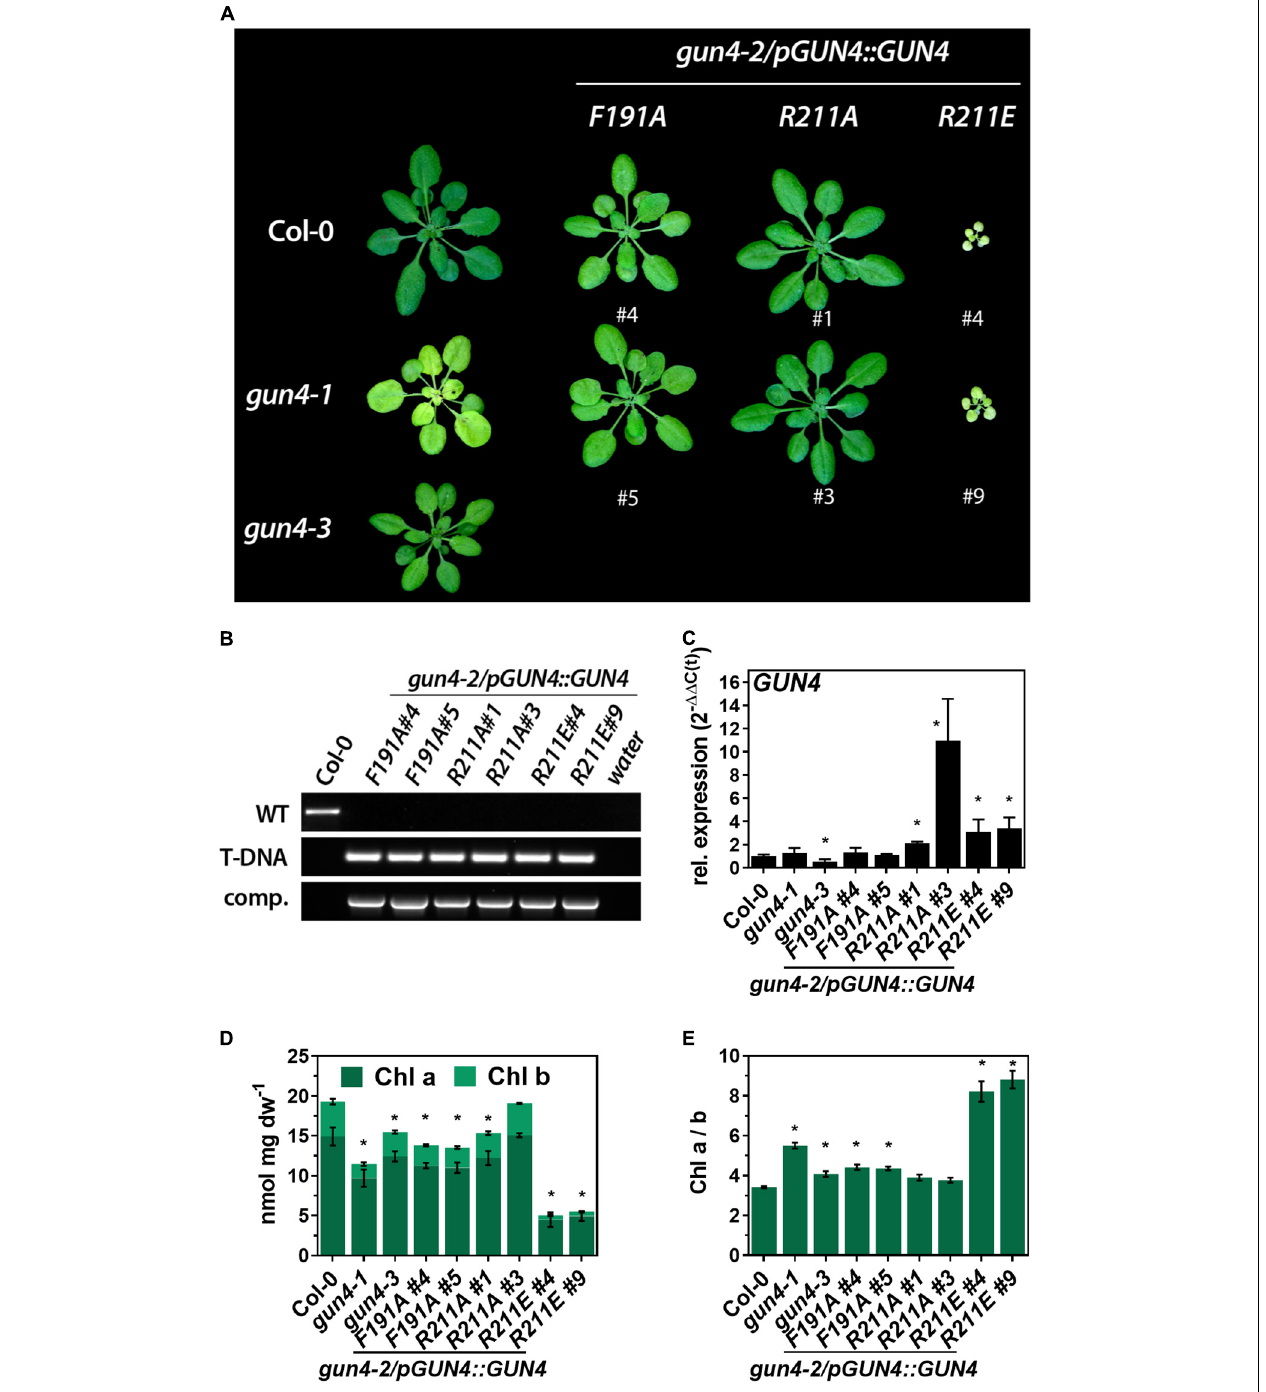
FIGURE 2 | Complementation of the gun4-2 knock out mutant with genomic constructs encoding for GUN4 ( F191A ), GUN4 ( R211A ), and GUN4 ( R211E ). (A) Phenotype of 5-week-old WT (Col-0) and mutant plants grown on soil under short-day conditions at 100 µ mol photons – 2 s – 1 . In addition, gun4-1 and gun4-3 knock out plants are shown. (B) PCR-based confirmation of the gun4-2 knock out background and presence of the complementation construct in the mutant lines shown in panel (A) using primers for the amplification of the GUN4 WT-allele (WT), the SALK_026911 T-DNA insertion (T-DNA) and the complementation construct (comp.) (C) Expression of GUN4 mRNA relative to Col-0 and SAND as reference gene [2 − ddC ( t ) ]. (D) Chlorophyll (Chl) a and b content and (E) Chl a/b ratio. Statistical significance relative to the WT (* p < 0.05) was calculated using one-way ANOVA and Dunnett’s multiple comparison test with n ≥ 3 (C) and n = 4 (D,E) replicates. Values are given as the mean ±